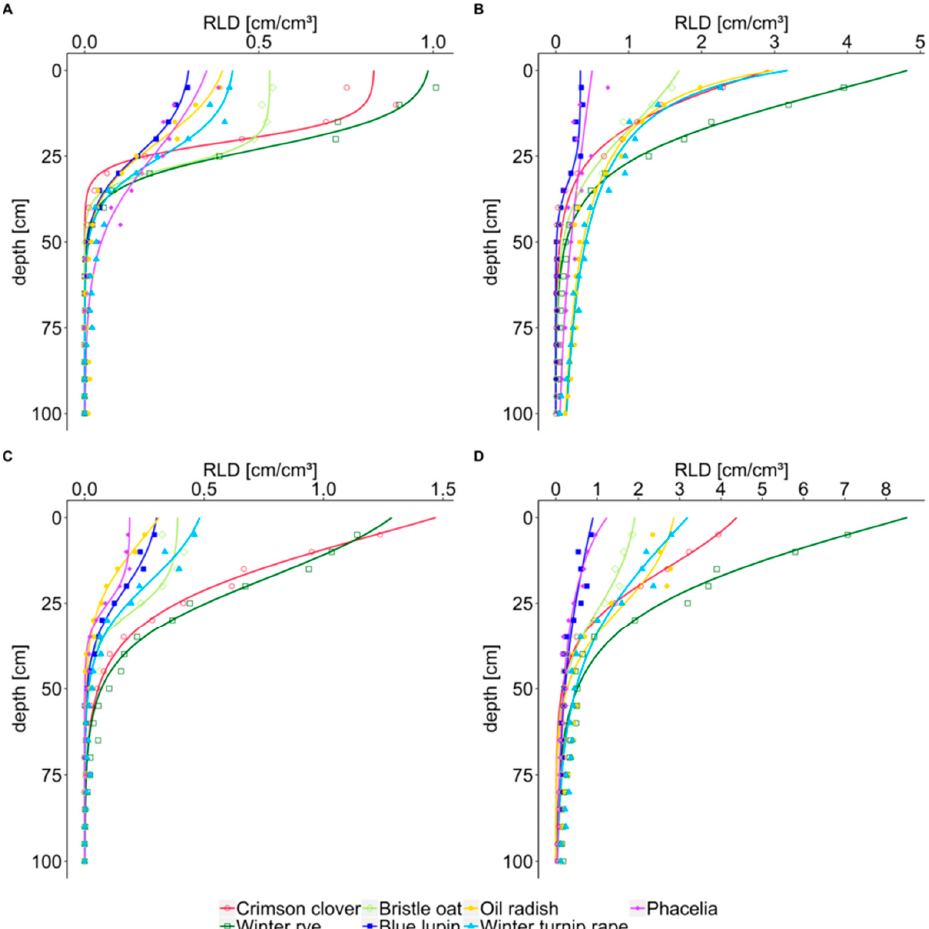
Figure 2. Root length density (RLD) of cover crops at different soil depth before winter ( A , B ) and after winter ( C , D ) in seasons 2018 / 2019 ( A , C ) and 2019 / 2020 ( B , D ). RLD was fitted by a non-linear regression using a three-parameter logistic function. Estimated parameters are shown in Table S1. Symbols show the means of the measured values ( n = 3).